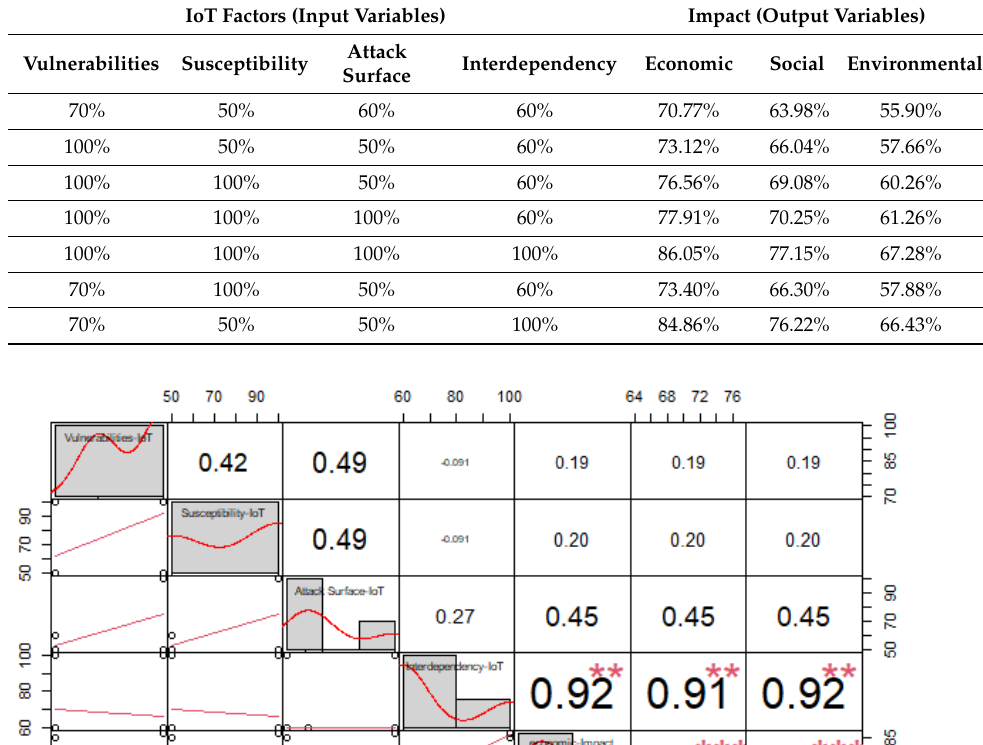
Table 11. Performance indices for the benchmark of risk methodology.